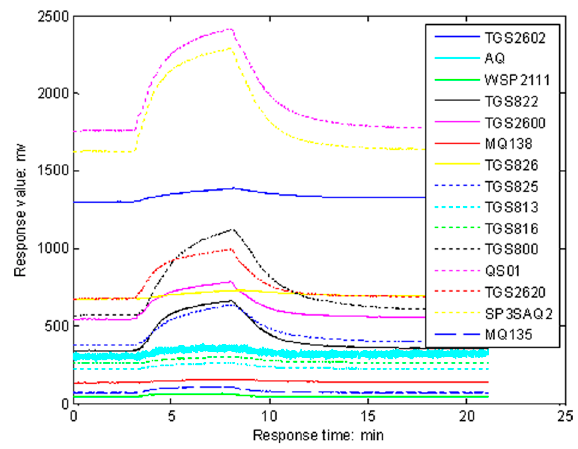
Figure 4. Response curves of 15 sensors on one wound infected with P. aeruginosa .